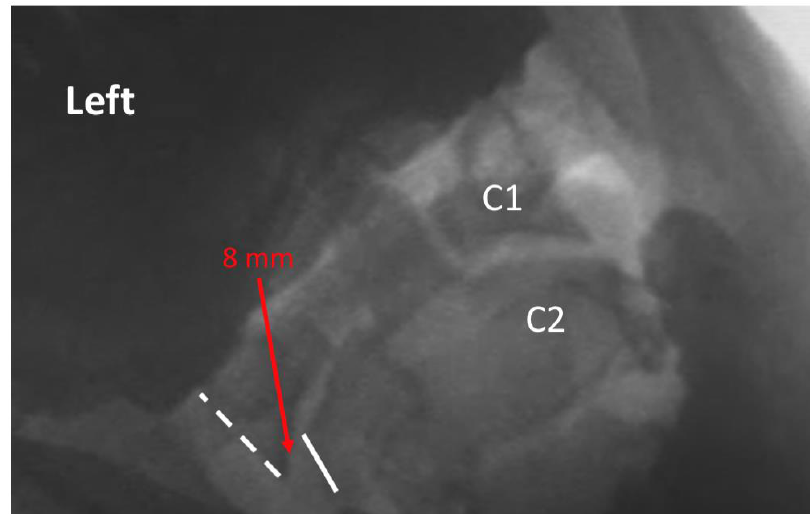
Figure 2. Exemplar of AP open mouth left lateral flexion view of C1 on C2, demonstrating abnormal alignment. The dashed line indicates the lateral border of the left lateral mass of C1, and the solid line indicates the lateral border of the left articular pillar of C2. The red arrow indicates 8 mm lateral translation of C1 on C2 during maximal voluntary lateral flexion. Note: the image has been reversed so that left on the image corresponds with the patient’s left. Int. J. Environ. Res. Public Health 2020 , 17 , x